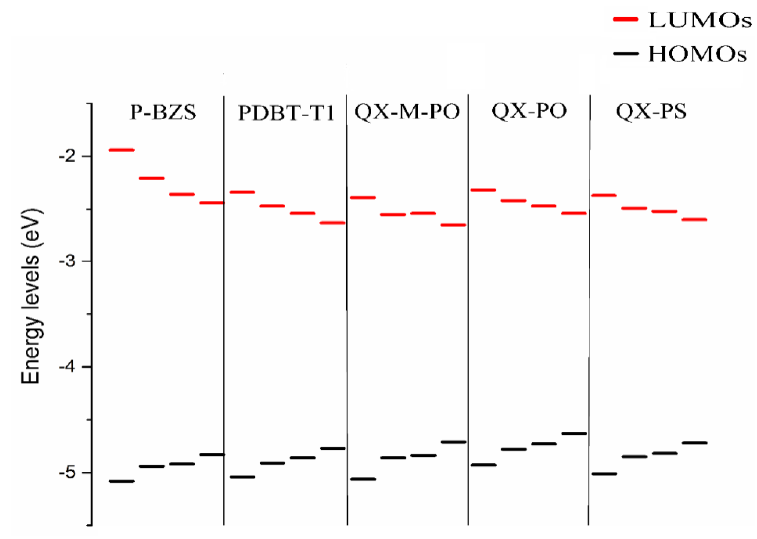
Figure 3. Energy levels of all oligomers ( n = 1–3 and n = ∞), where the black line and red line stand HOMO and LUMO, respectively.